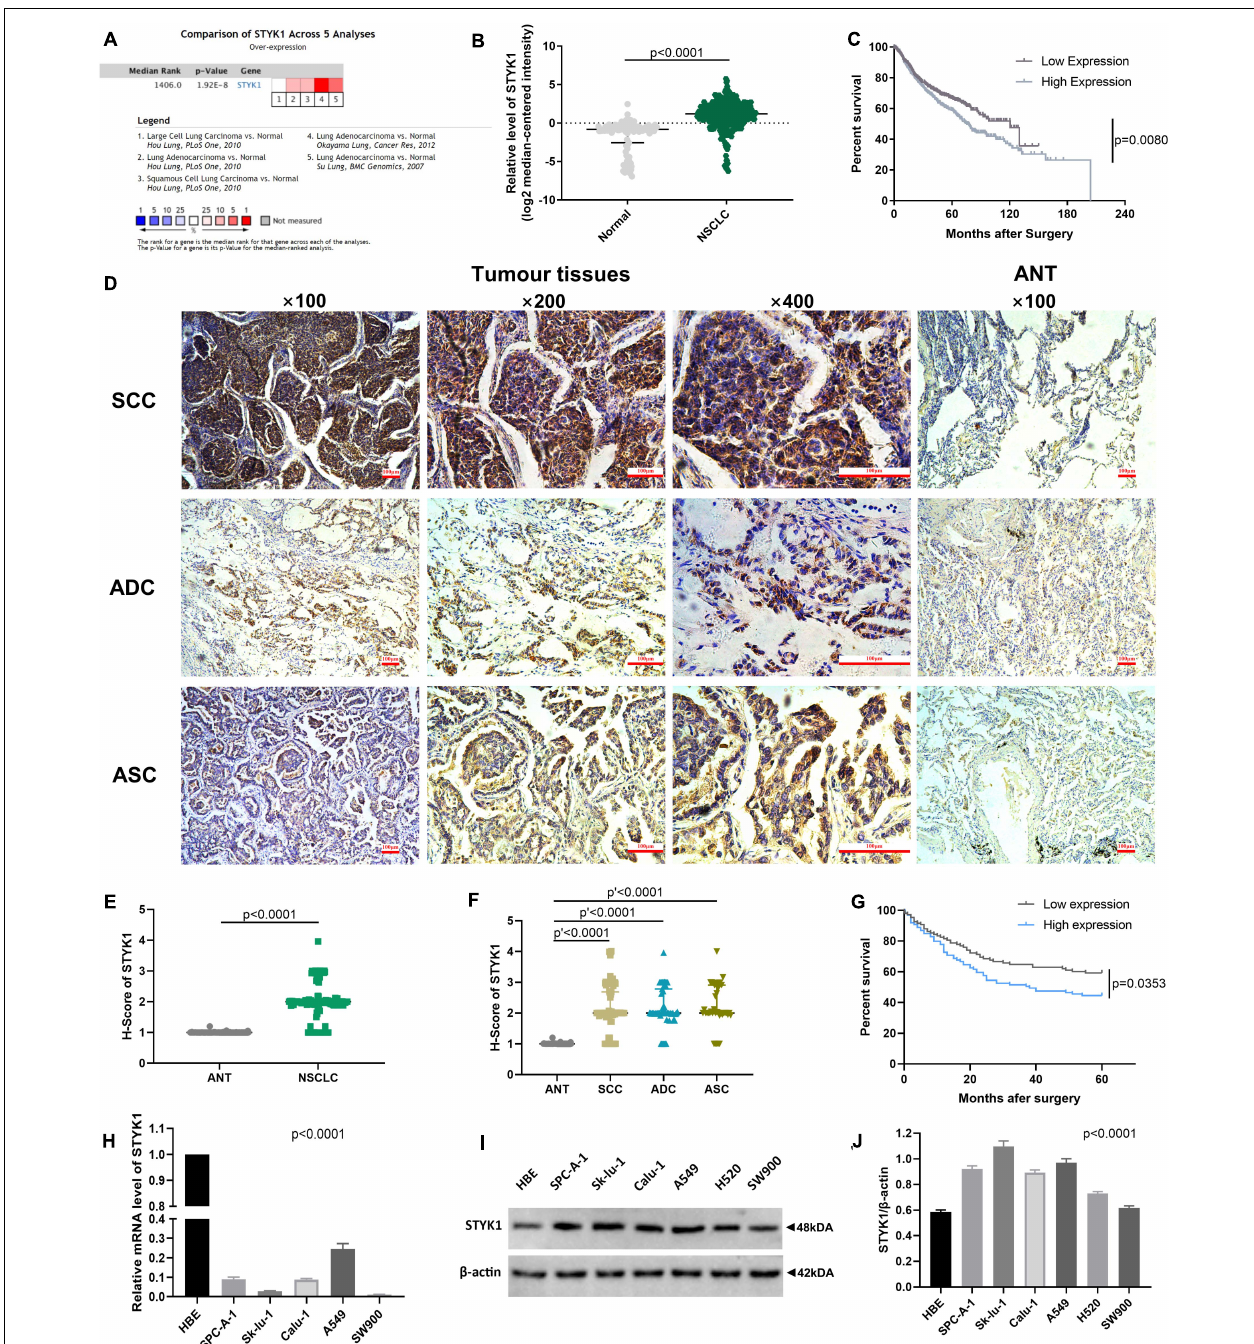
FIGURE 1 | STYK1 expression is upregulated in NSCLC tissues and cells and correlates with poor prognosis. (A) STYK1 mRNA level evaluated by meta-analysis; data were mined from three ONCOMINE datasets (Su et al., 2007; Hou et al., 2010; Okayama et al., 2012). (B) STYK1 mRNA levels in NSCLC ( n = 345) and normal lung tissues ( n = 115) from previous ONCOMINE datasets; P < 0.0001, Mann-Whitney test. (C) Relationship between STYK1 mRNA level and overall survival in 938 NSCLC cases from five ONCOMINE datasets (Raponi et al., 2006; Shedden et al., 2008; Kuner et al., 2009; Hou et al., 2010; Okayama et al., 2012) (high/low expression was defined as mRNA expression value higher/lower than the median); P = 0.0080, log-rank Mantel-Cox test. (D) Typical STYK1 IHC signal in NSCLC and adjacent normal lung tissues. (E,F) H-scores of STYK1 in NSCLC and adjacent normal lung tissues; P < 0.0001, Wilcoxon matched-pairs signed rank; P (cid:48) < 0.0001, Kruskal-Wallis test followed by Dunn’s multiple comparisons test. (G) Comparison of post-operative survival curves between patients with high or low STYK1 expression ( n = 208; high or low expression, h-score higher or lower than the median); P = 0.0353, log-rank Mantel-Cox test. (H–J) mRNA, immunoblots, and semiquantitative analysis of STYK1 expression in lung cancer cell lines; P < 0.0001, ANOVA. SCC, squamous cell carcinoma; ADC, adenocarcinoma; ASC, adenosquamous carcinoma; ANT, adjacent normal lung tissues.